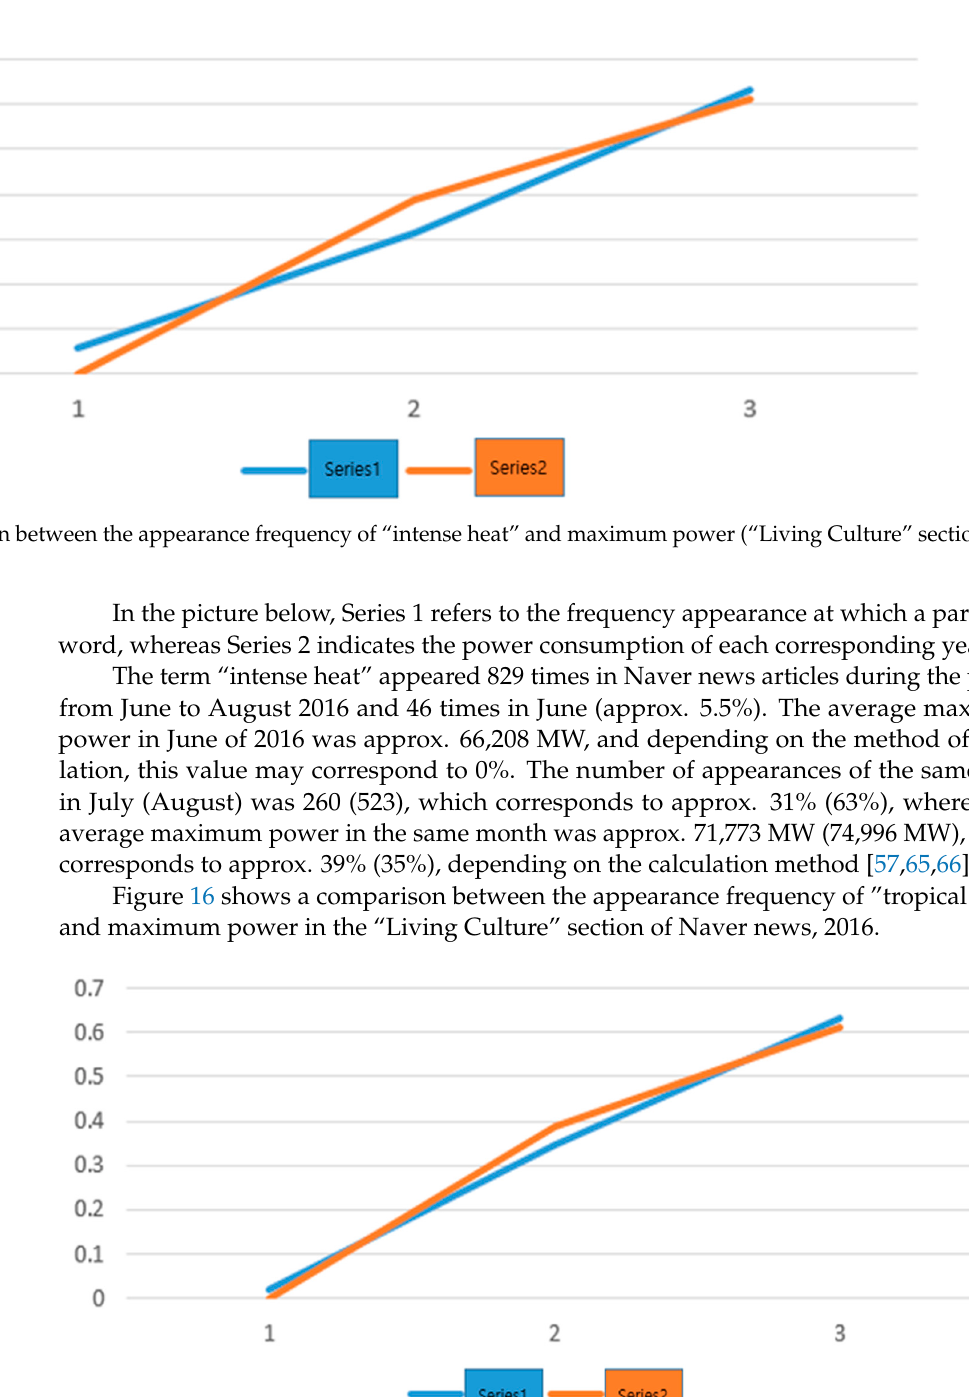
Figure 17. Comparison between the appearance frequency of “mosquito” and maximum power (“Living Culture” section of Naver news, 2016). The total number of appearances of the term “mosquito” in Naver news articles dur- ing the period from June to August of 2016 was 129, 26 of which were in June, correspond- ing to approx. 20%. The average maximum power in June of 2016 was approx. 66,208 MW, and depending on the method of calculation, this value may correspond to 0%. The num- ber of appearances of the same term in July (August) was 57 (46), which corresponds to approx. 44% (36%), whereas the average maximum power in the same month was approx. 71,773 MW (74,996 MW), corresponding to approx. 39 (35%), depending on the calculation method [58]. Figure 18 shows a comparison between the appearance frequency of “intense heat” and maximum power in the “Living Culture” section of Naver news, 2017. The total number of appearances of the term “intense heat” in Naver news articles in the period from June to August of 2017 was 1015, 187 of which were in June, correspond- ing to approx. 18%. The average maximum power in June of 2017 was approx. 67,000 MW,